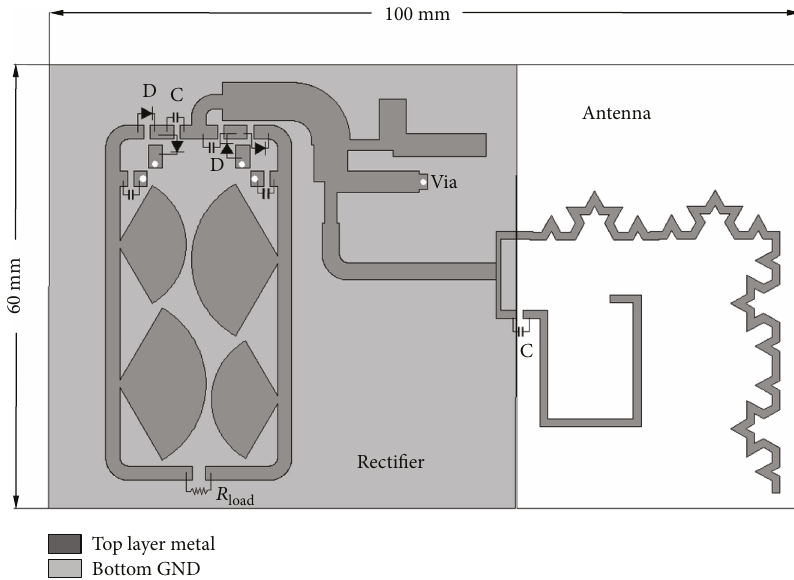
Figure 1: Layout of the proposed dual-band rectenna.